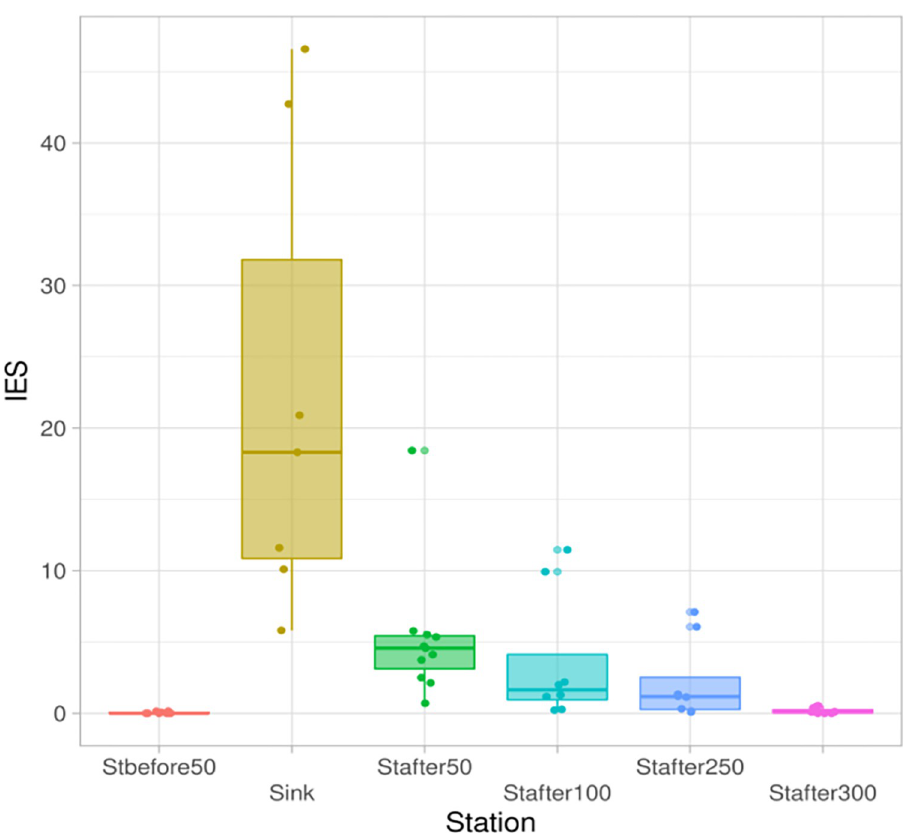
Fig 9. Attached form index (AFI) change by station in the environmental gradient based on data for the entire study period AFI by station.